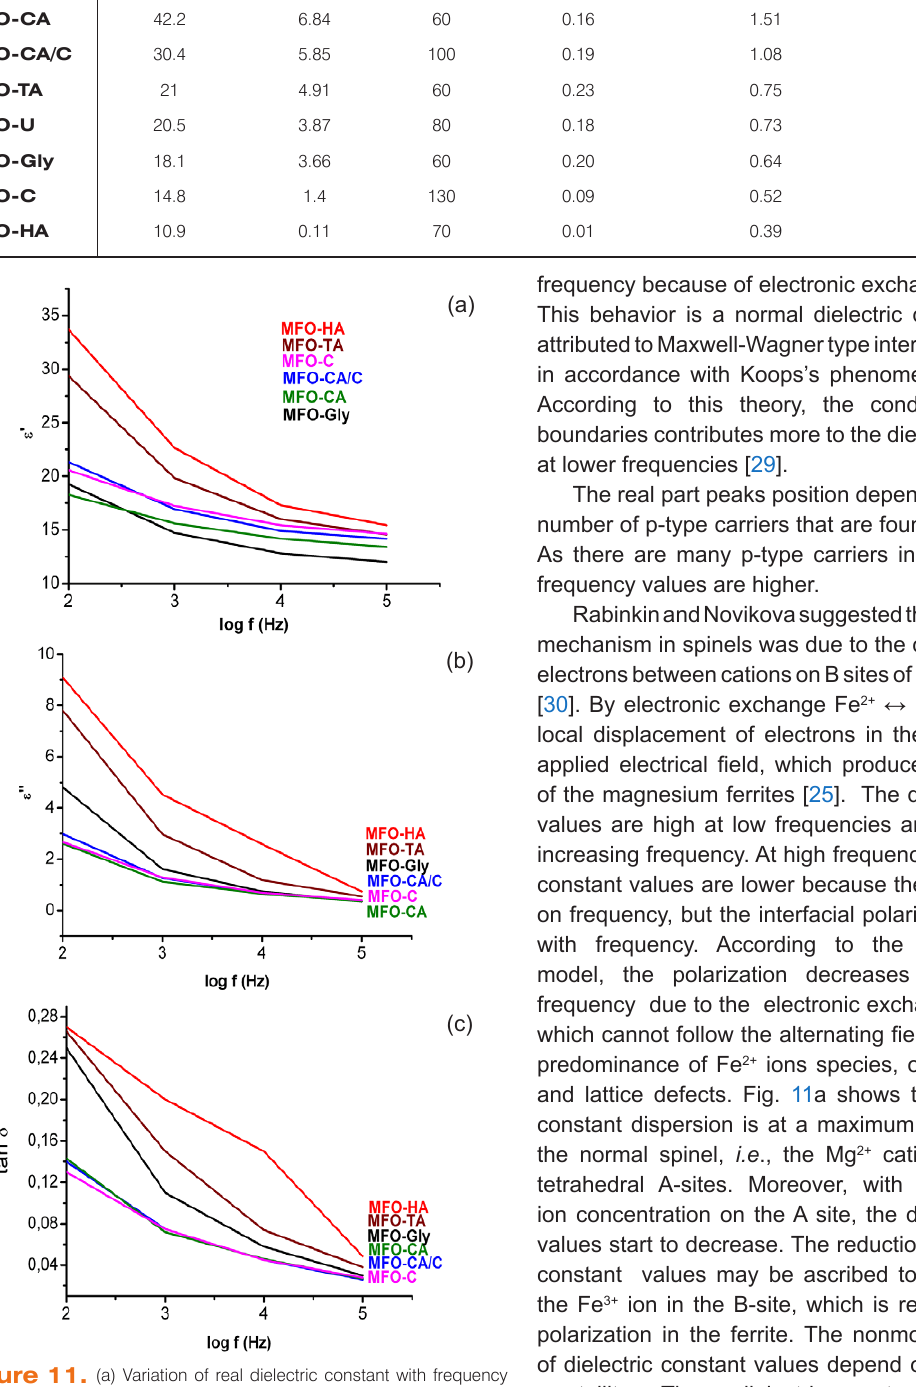
Figure 11. (a) Variation of real dielectric constant with frequency for MFO heat treated at 1173 K; (b) The imaginary part function frequency for MFO heat treated at 1173 K; (c) Dielectric loss factor function on frequency for the MFO heat treated at 1173